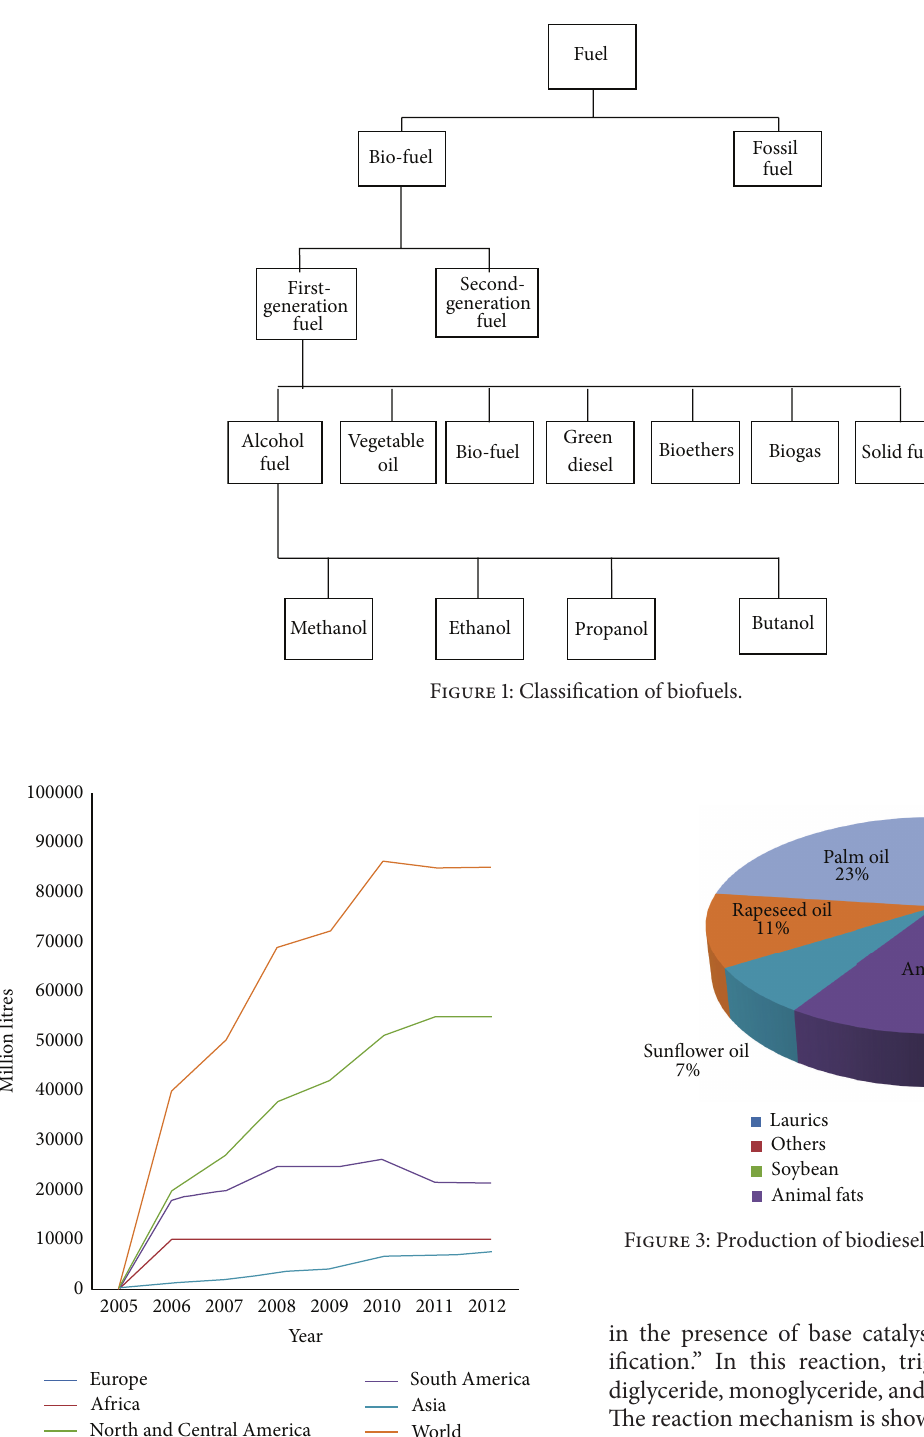
Figure 2: Production of biodiesel in recent years [7].